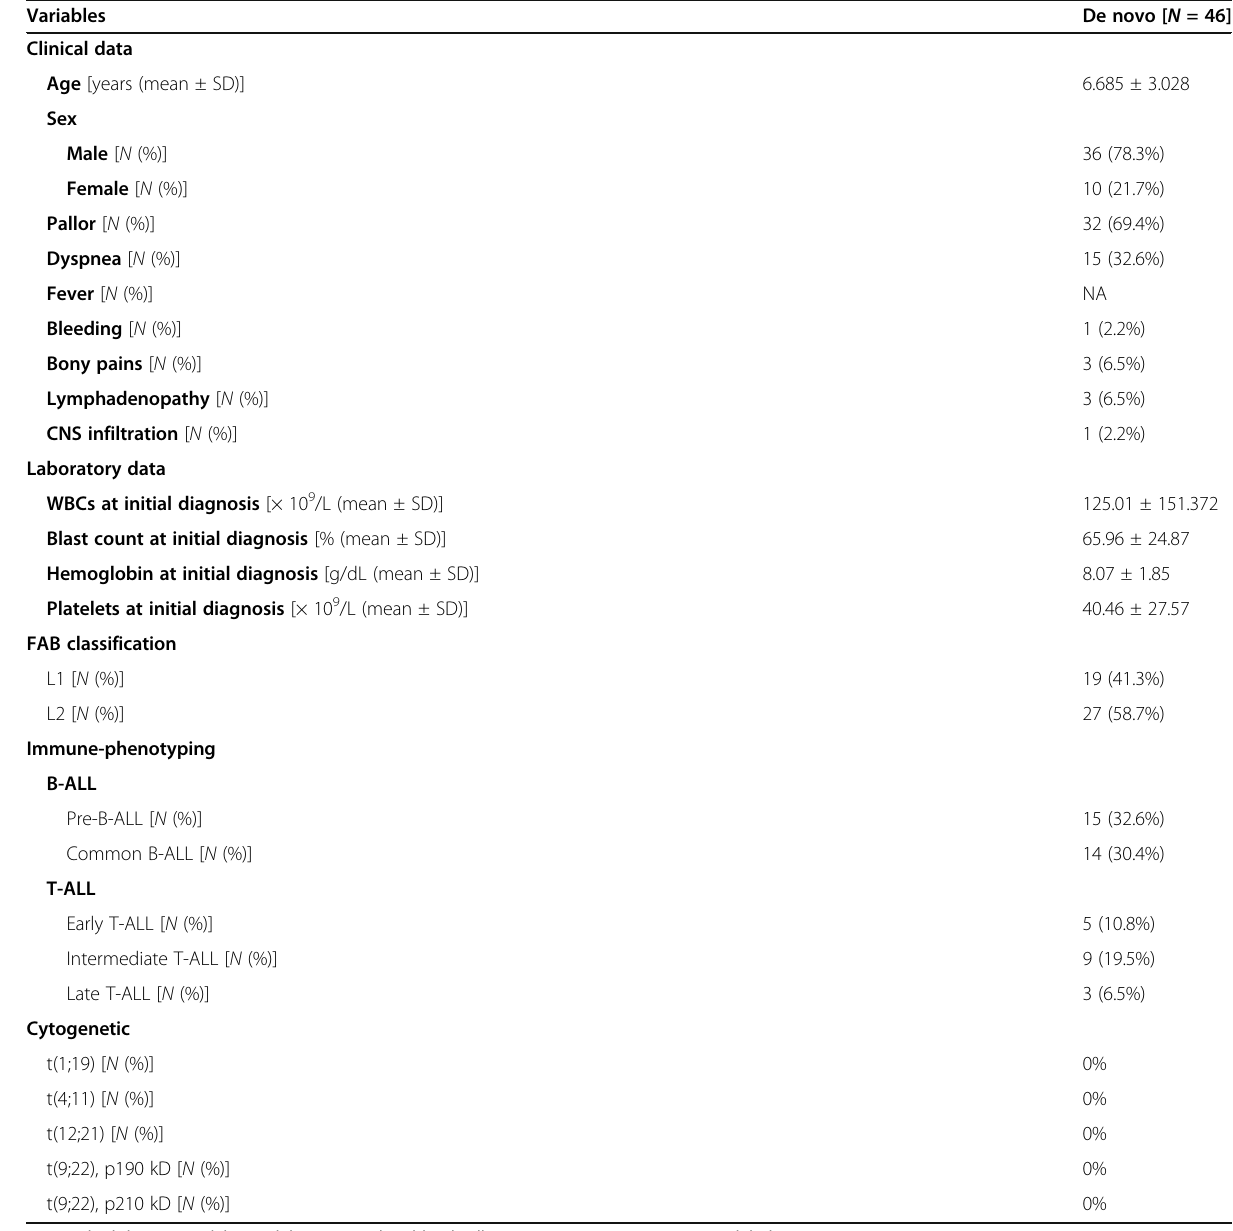
Table 2 Clinical and laboratory data of the de novo patients Variables De novo [ N = 46] Clinical